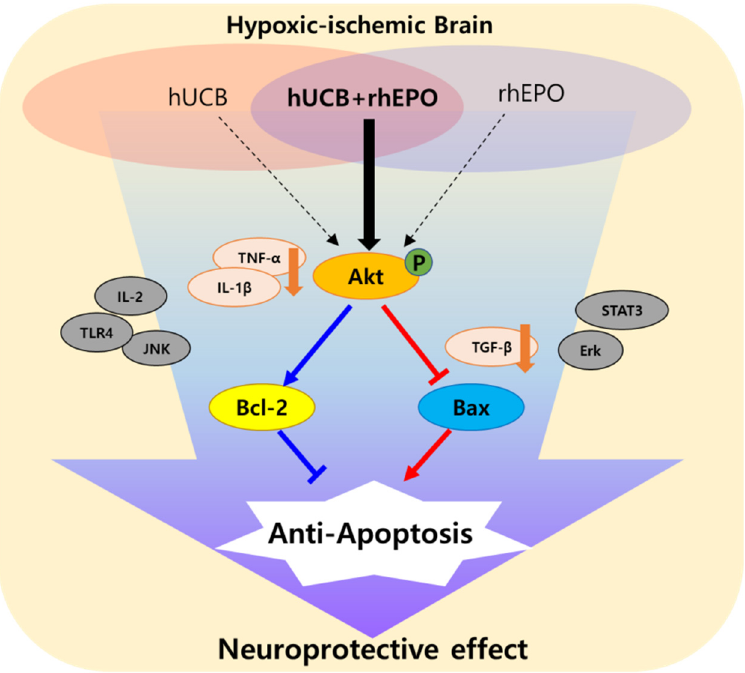
Figure 7. Summary figure. The combination treatment with rhEPO in hUCB therapy improves syn- ergistic neuroprotective effects from the HIE injury through Akt-mediated anti-apoptotic responses in the HIE brain.